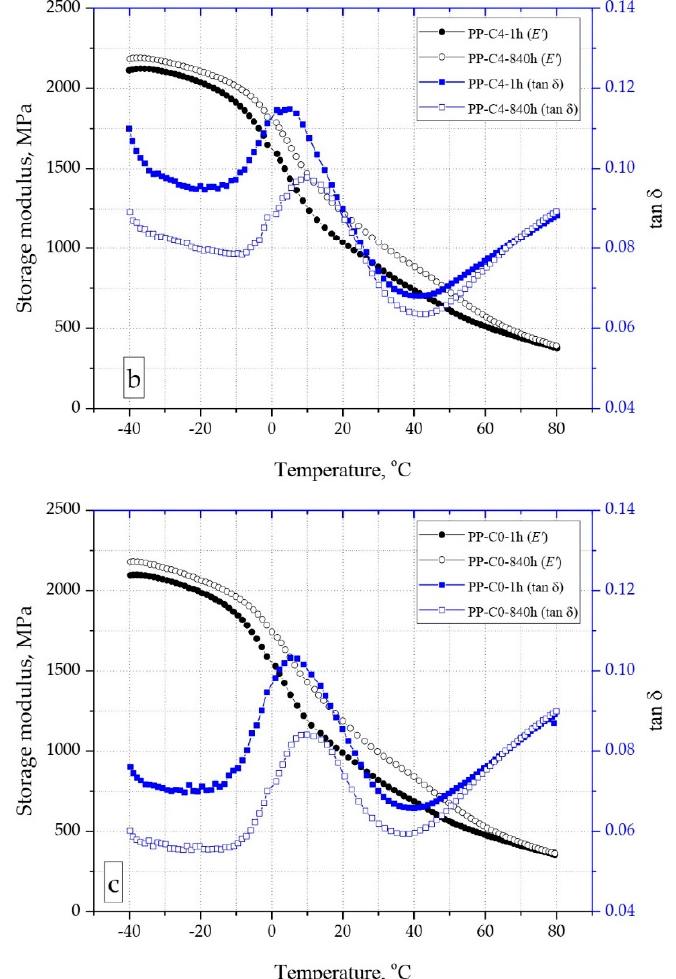
Figure 11. Storage modulus and mechanical loss factor of polypropylene samples: PP ( a ), PP-C4 ( b ), PPC0 ( c ). PPC0 ( c PPC0 ( c ) .